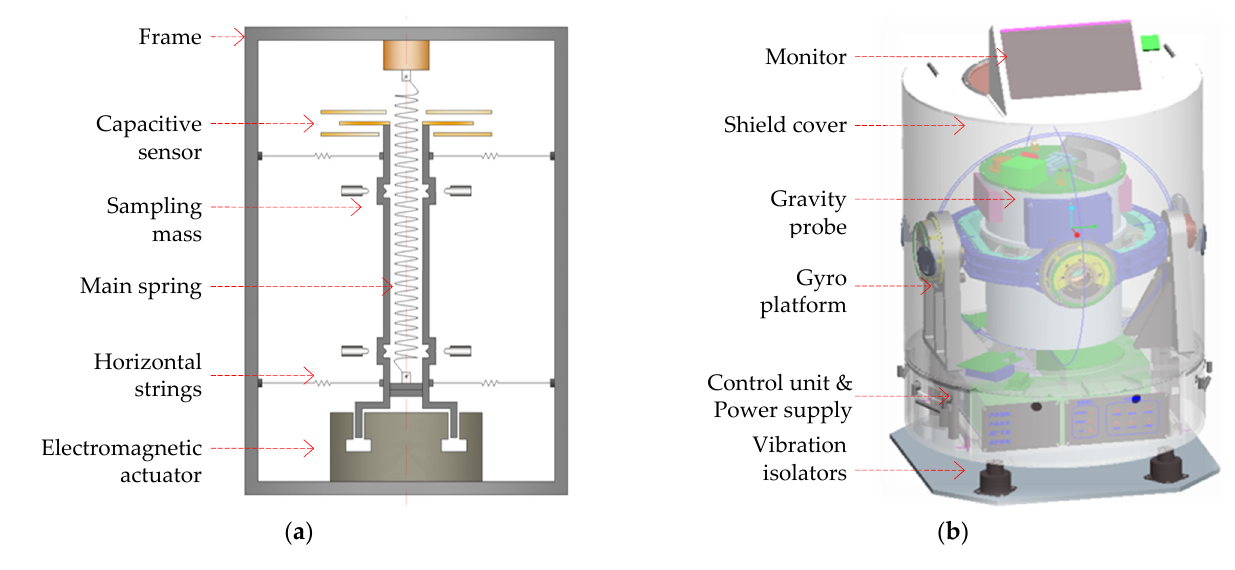
Figure 1. CHZ-II gravimeter. ( a ) Schematic diagram of the gravity probe, which is constructed with a cylindrical sampling mass suspended by a spring. Two groups of horizontal strings are used to constrain the motion of the sampling mass with respect to the frame, except for the displacement along the axis of the spring. An electromagnetic actuator is used for the feedback control of the sampling mass. ( b ) System components, with the probe supported by a two-axis gyro platform.